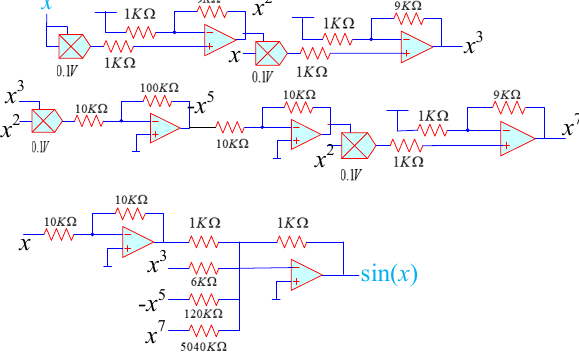
Figure 13. Realization circuit of the sinusoidal function.